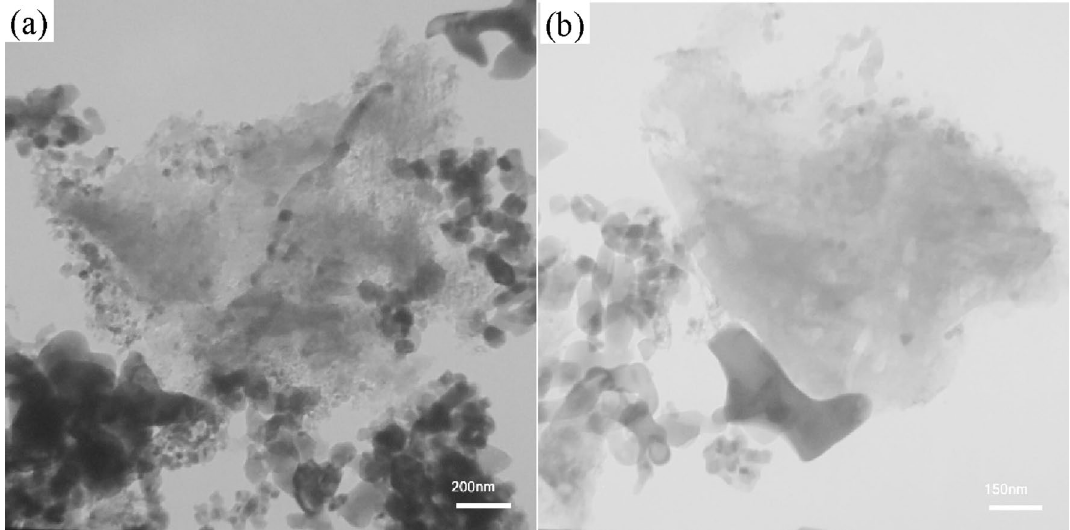
Figure 3. TEM images of the X5 composite